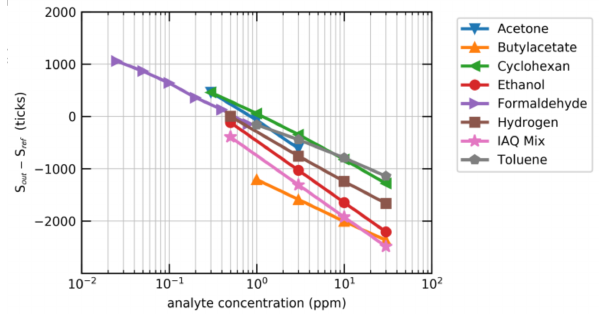
Figure 6. Sensor output ( S out ) normalized to the sensor signal at 0.5 ppm H 2 ( S ref ) as function of the analyte concentration for various gases. Indoor air quality (IAQ) Mix refers to a gas mixture proposed by Mølhave et al. [39] representing a typical mixture of volatile organic compounds (VOCs) found in indoor environments.